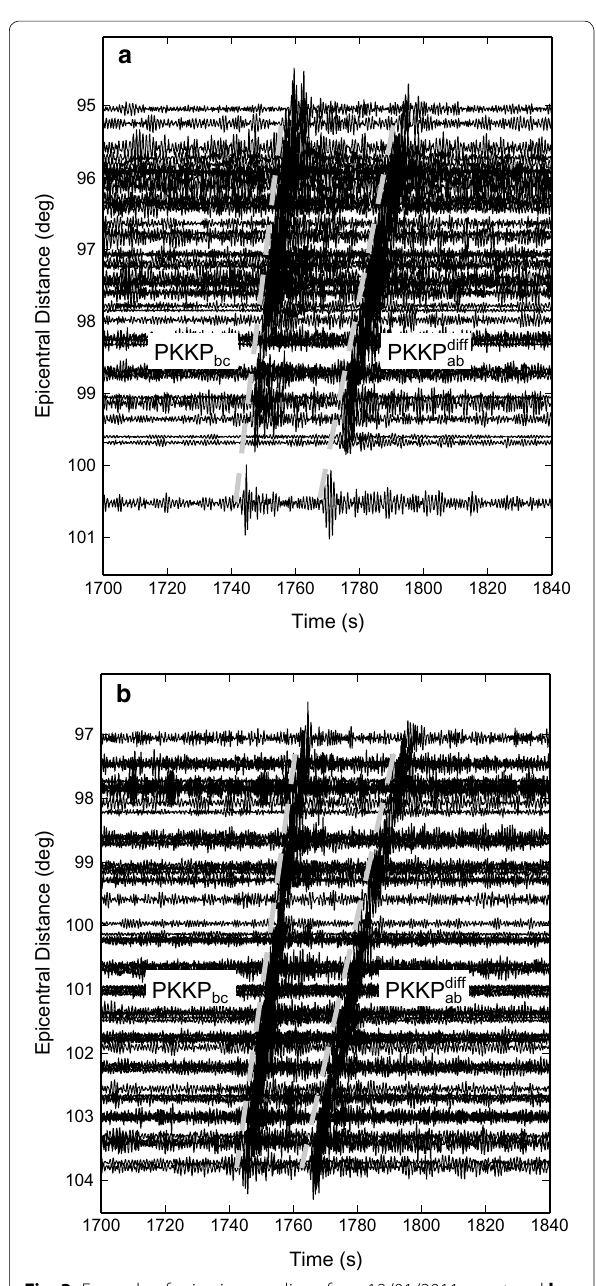
Fig. 3 Example of seismic recordings for a 12/01/2011 event and b 21/04/2013 event, respectively. They show clear PKKP bc and PKKP ab diffraction phases and the theoretical travel times of these two phases are denoted by gray dashed